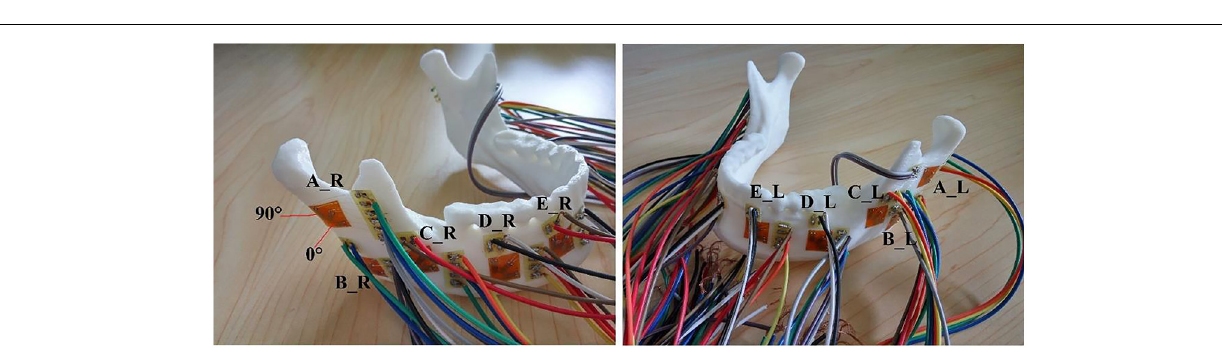
FIGURE 2 | The distributions of 10 strain rosettes on the mandible: A located at the bilateral mandibular condyle necks, B located at the bilateral mandibular angles, and C, D, and E located at the bilateral mandibular bodies. R and L represented the right and left sides, respectively.